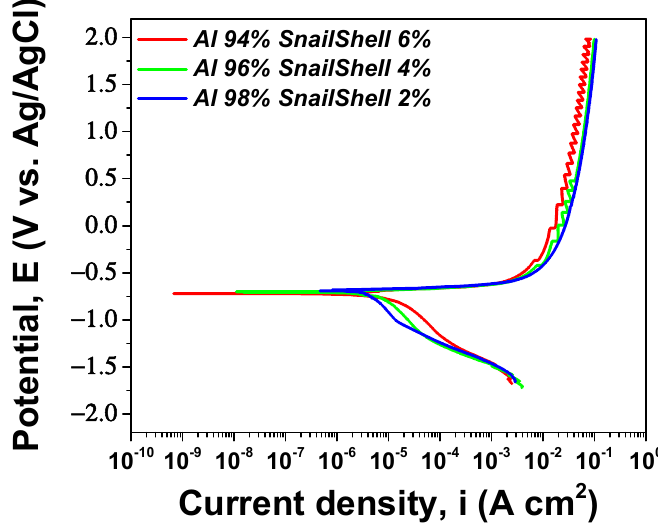
Figure 7. Potentiodynamic curves of the investigated specimens.